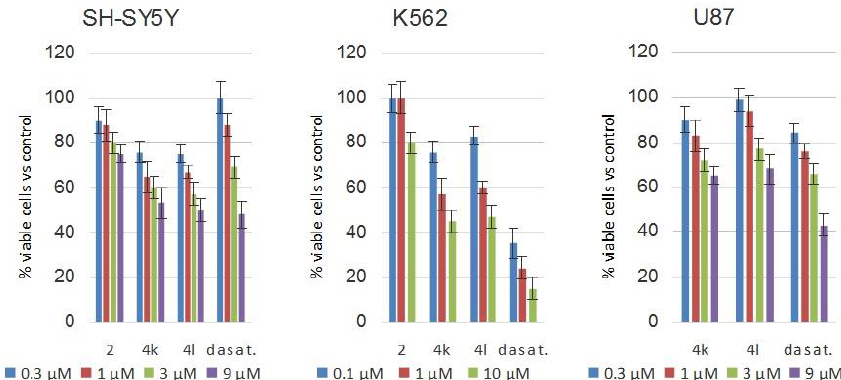
Figure 6. Antiproliferative effect of 4k and 4l evaluated by in vitro analysis of percentage of viable cells after 72 h of incubation with SH-SY5Y, K562, and U87 cells. Dasatinib was used as reference compound. Antiproliferative activity of compound 2 in SH-SY5Y and K562 cells has been also reported. Percentage was calculated respect to the number of cells treated with the vehicle (100%, bar not shown in the graph).